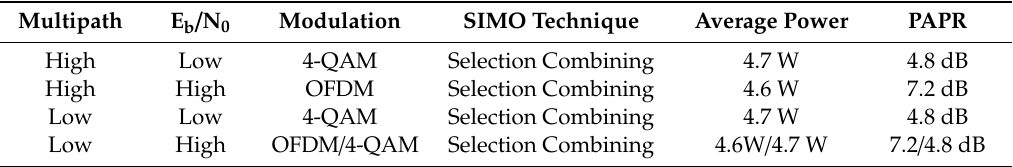
Table 5. Modulation depending on